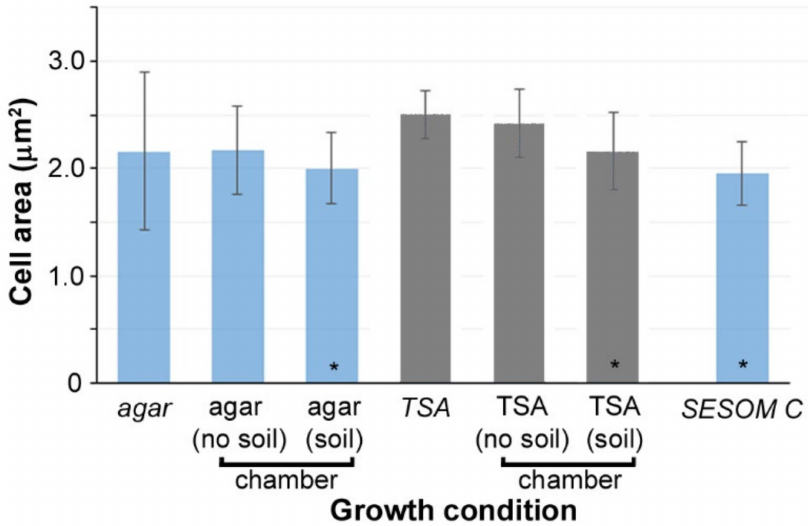
Figure 3. The mean cell size for Yersinia pestis grown under di ff erent conditions. Conditions in italics represent the growth in regular plates, whereas the others were grown in the 3D printed cell culture chambers. *—represents the soil or soil-like conditions (SESOM). In general, the cell size did not change whether grown on plates or in the chamber, reflecting that the chamber itself did not influence cell size. However, in both soil and soil-like conditions, the average cell size decreased. At least five cells were analyzed for each